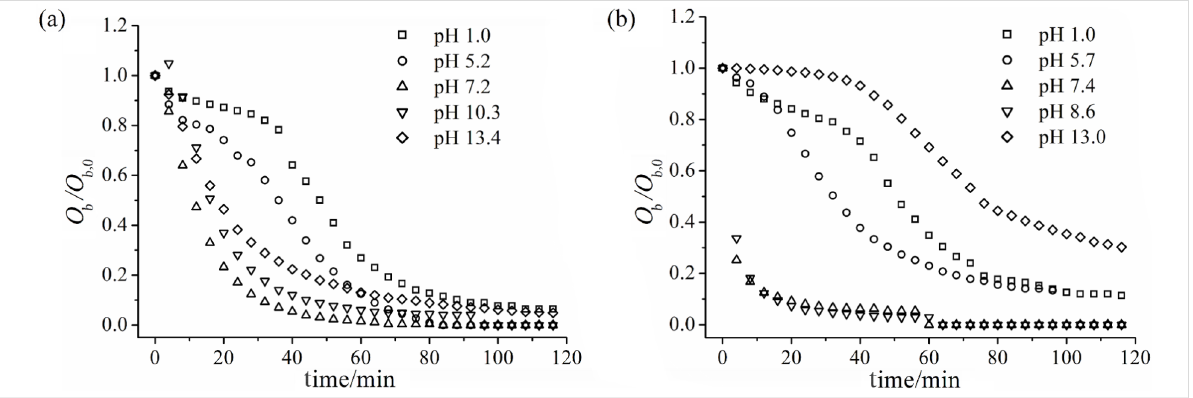
Figure 6: Relative optical obscuration ( O b / O b,0 ) as a function of time for (a) Fe-Ni/Zn and (b) Fe-Ni/Zn/ β CD.